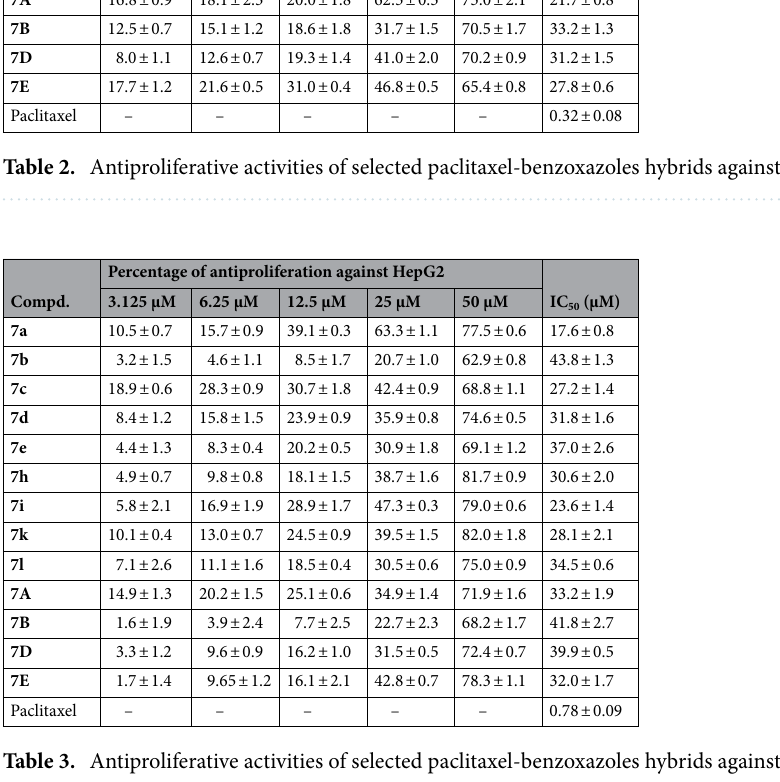
Table 3. Antiproliferative activities of selected paclitaxel-benzoxazoles hybrids against HepG2.